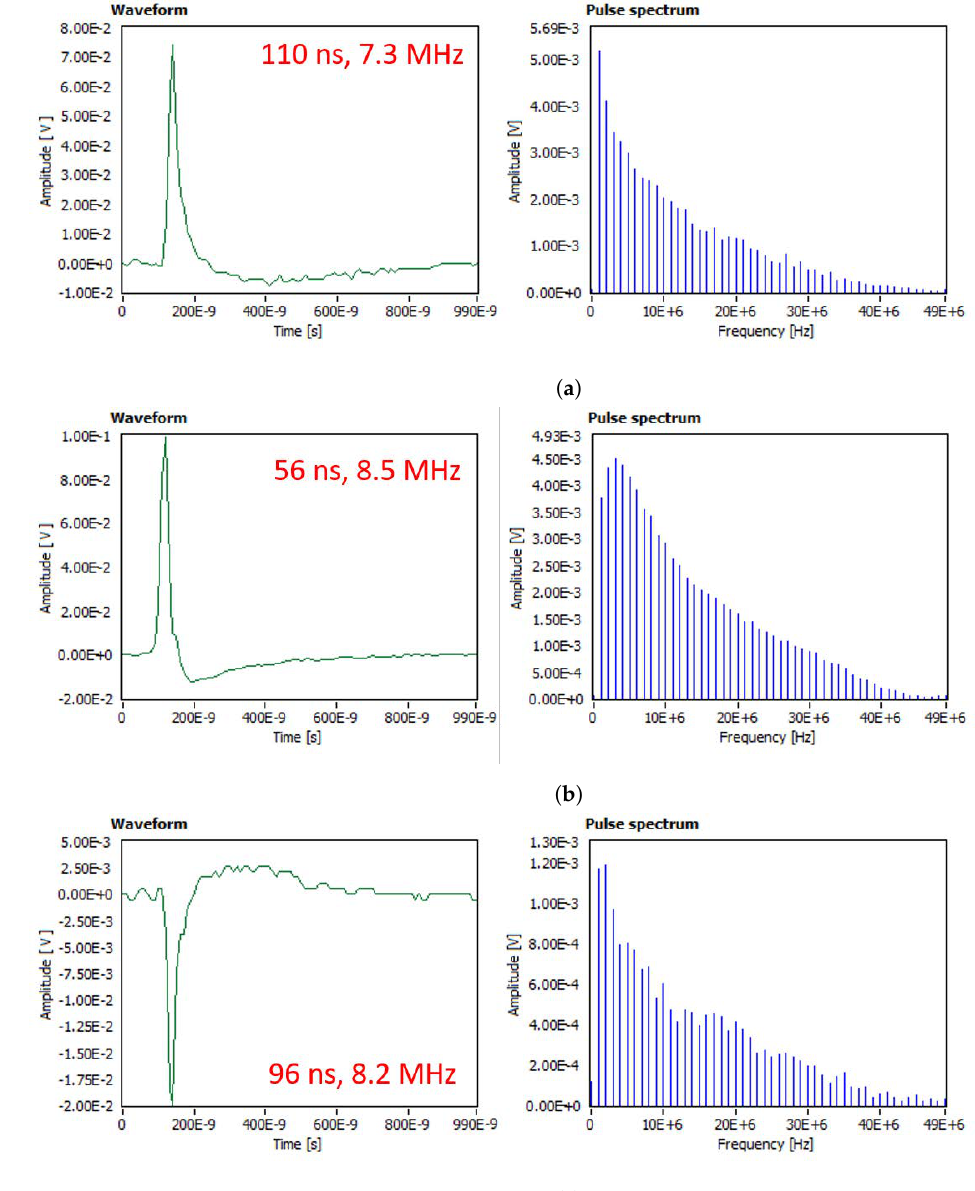
Figure 8. Localized discharge pulse waveforms and corresponding frequency spectra. T 2 , W 2 coordinates of each pulse are shown on the time domain graphs. ( a ) AC pulse. ( b ) Negative DC pulse. ( c ) Positive DC